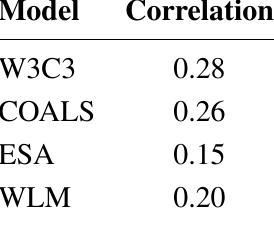
Table 11. Pearson correlations with NMS (N =